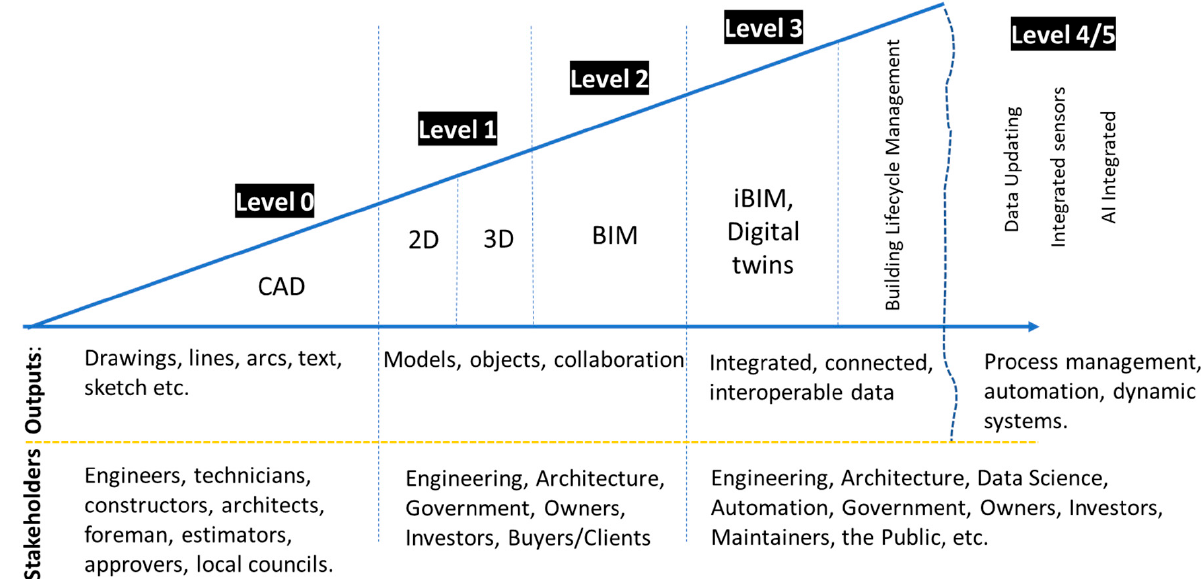
Figure 2. BIM Metrics and maturity levels, modified from [28]. Table 1. Level of BIM maturity